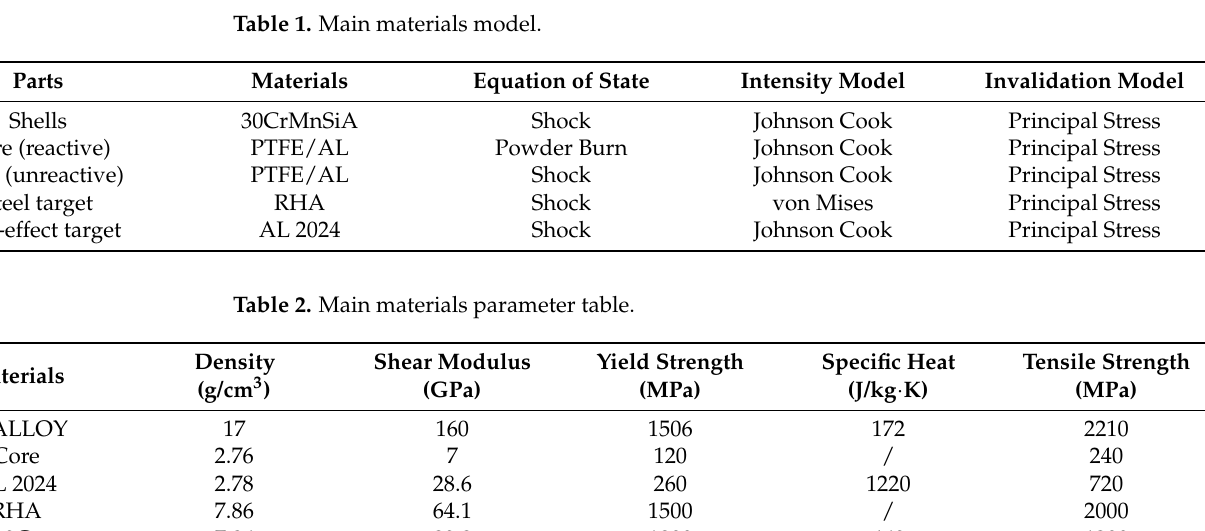
Table 1. Main materials model.